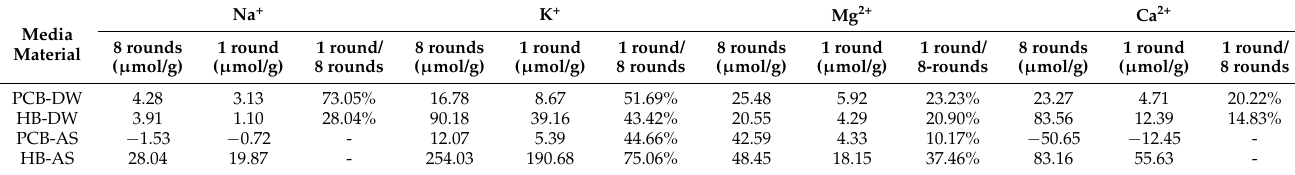
Table 3. Cations leaching quantities of PCB and HB in DW or